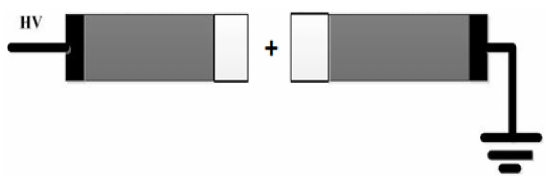
Figure 6. Dry band in the middle region.